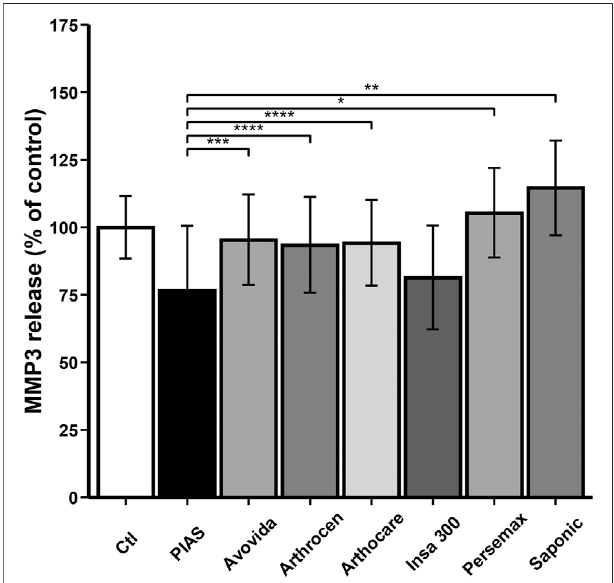
FIGURE 6 | Effect of ASU products tested on total MMP-3 production. The chondrocytes were cultured for 12 days either without any ASU (negative control, Ctl) or with 10 µg/ml of either PIASCLEDINE-ExpASU ® (PIAS) or one of the six other nutraceutical products being evaluated in comparison, namely, Avovida, Arthrocen, Arthocare, Insaponi fi able 300 (Insa 300), Persemax, or Saponic. Each product has been tested on six independent cultures. Each culture condition was performed in triplicates. The results are expressed as the percent control and represented by the mean ± SD. * p < 0.05 versus PIASCLEDINE-ExpASU ® , ** p < 0.01 versus PIASCLEDINE- ExpASU ® , *** p < 0.001 versus PIASCLEDINE-ExpASU ® , and **** p < 0.0001 versus PIASCLEDINE-ExpASU ®